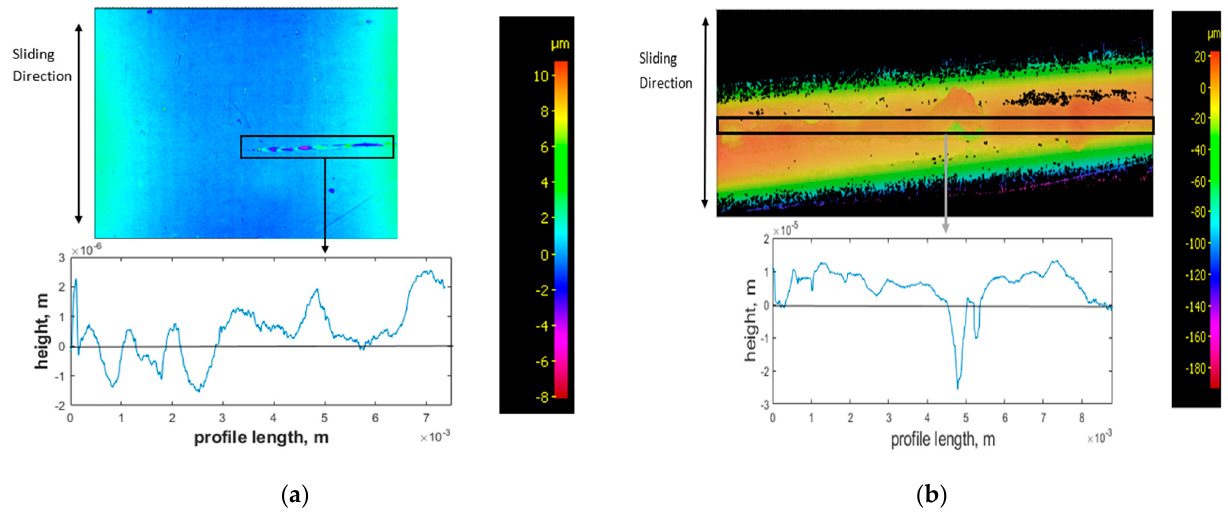
Figure 5. Adhesive test specimens, contour image, and corresponding graphical profiles of worn region after testing for ( a ) steel plate and ( b ) PEEK rods. Regions of high height show wear particle transfer from PEEK to steel plate, indicating adhesion.